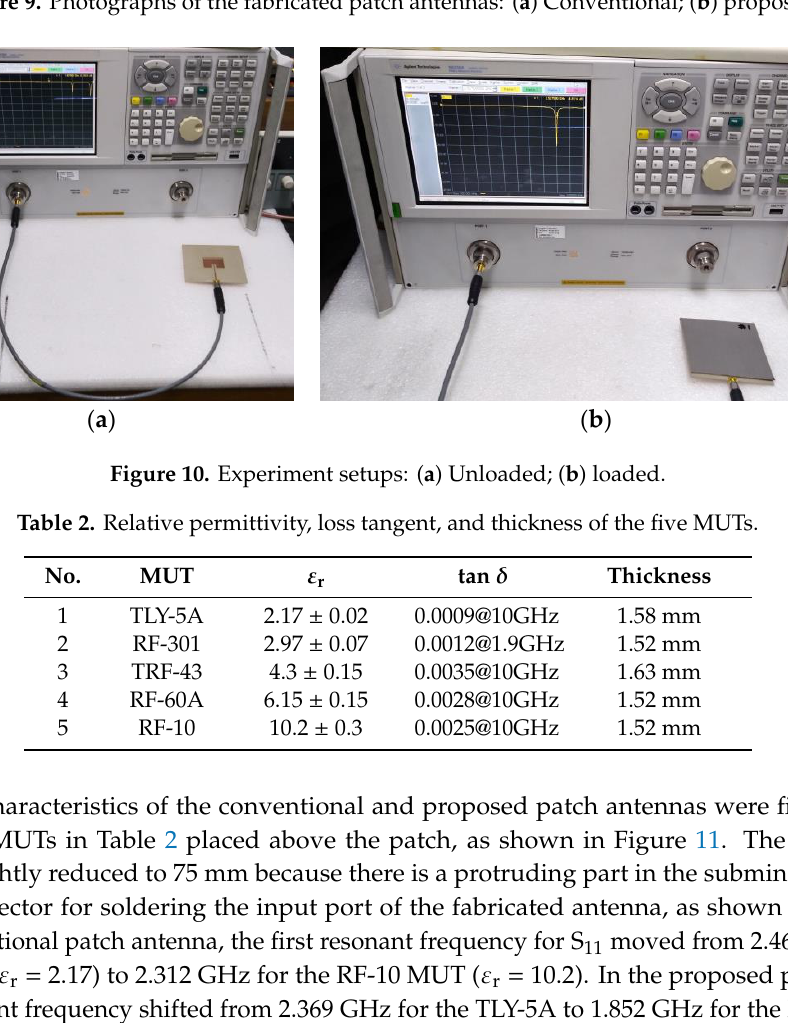
Figure 9. Photographs of the fabricated patch antennas: ( a ) Conventional; ( b ) proposed.